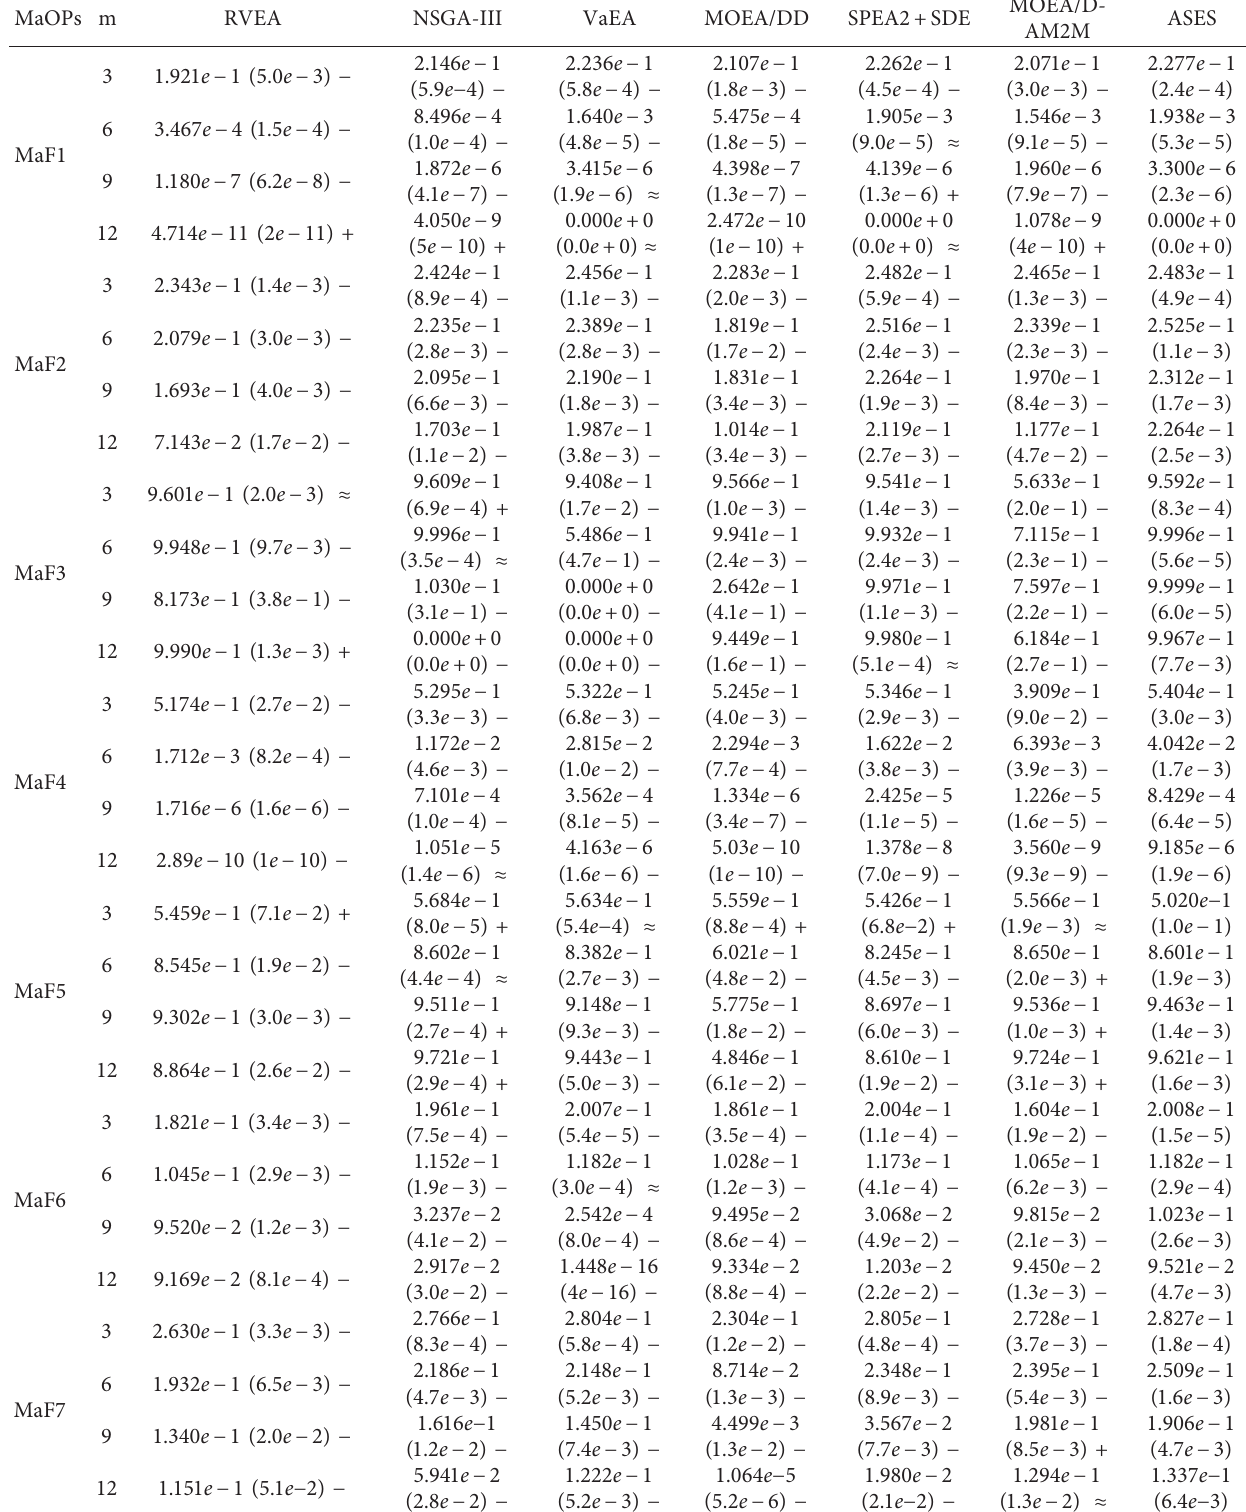
Table 2: Comparison of HV values of the seven algorithms on solving 3-, 6-, 9-, and 12-objective test functions MaF1–MaF13. MaOPs